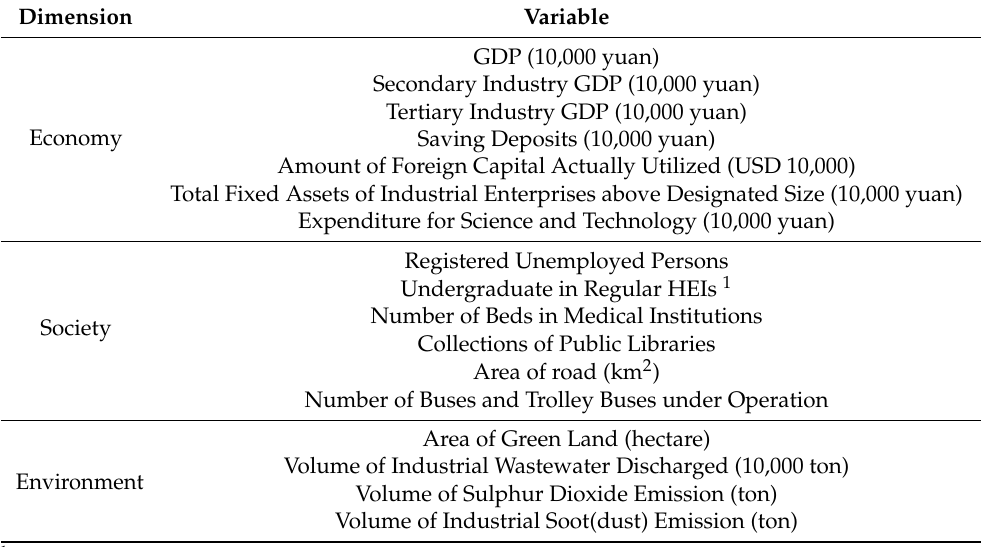
Table 1. Urban resilience